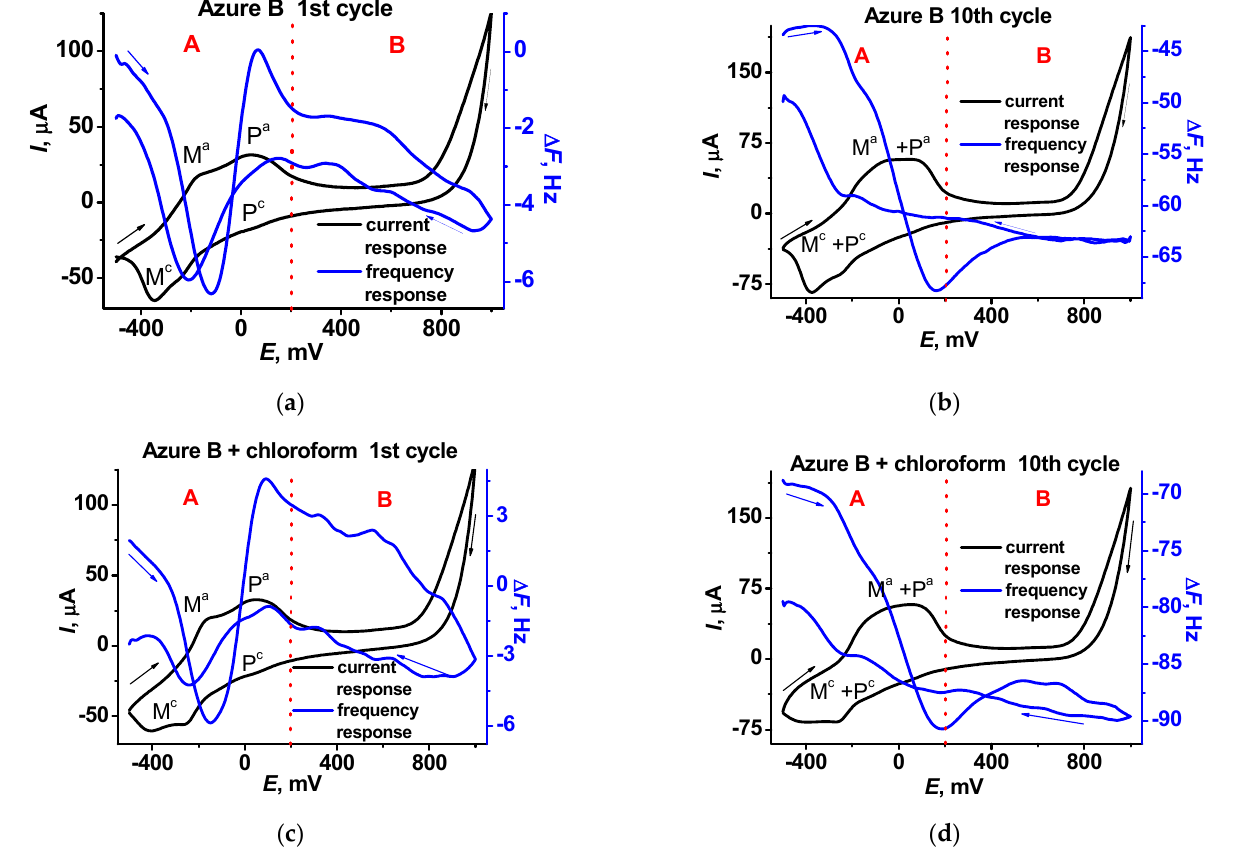
Figure 5. Cyclic voltammograms (black) and sensograms (blue) recorded on QCM chip in 0.1 M HEPES buffer containing 0.03 M NaNO 3 , pH = 7.0 ( a , b ) and saturated with chloroform ( c , d ), in the presence of 0.5 mM Azure B. Arrows indicate the direction of the potential scan.